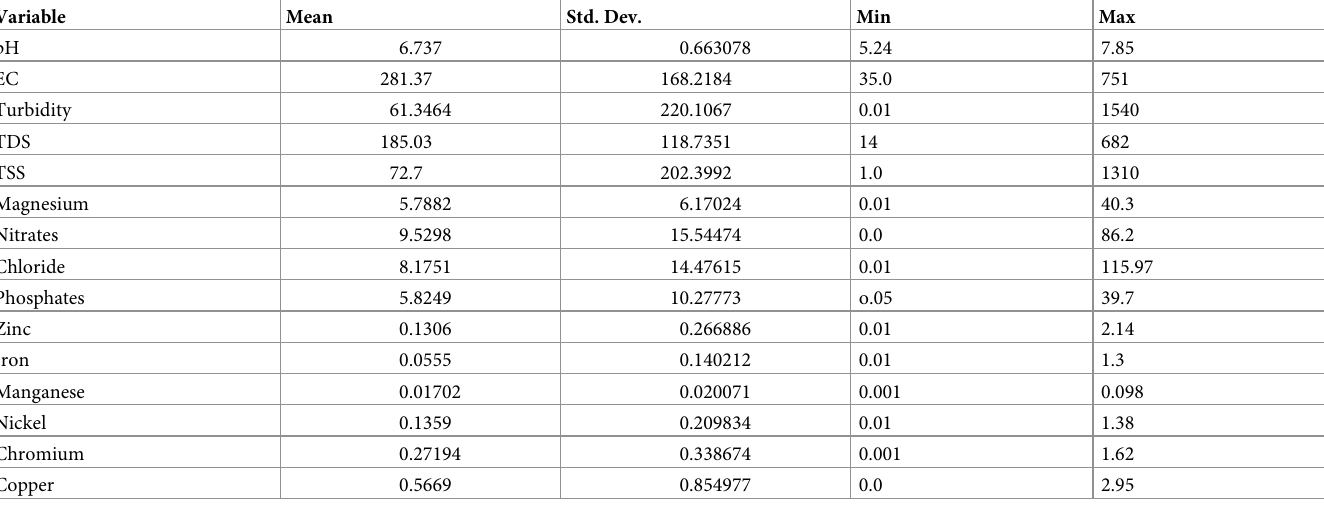
Table 2. Descriptive statistics of ground water samples (n =